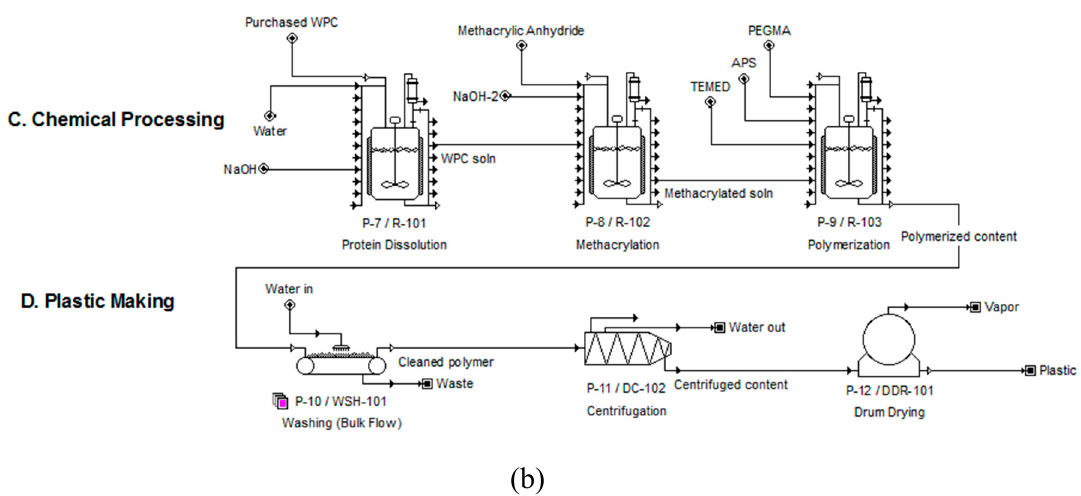
Figure 1. Process flow diagrams of bioplastics production using SuperPro Designer ® for ( a ) Scenario 1, and ( b ) Scenario 2.